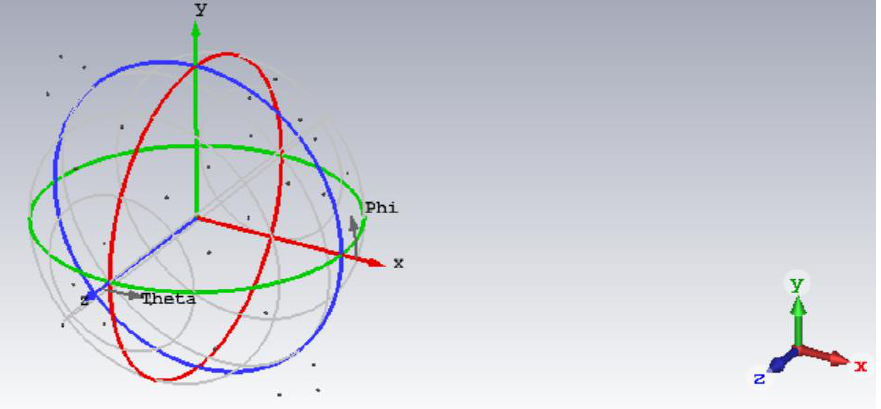
Figure 28. Electromagnetic simulation Experiment Ⅰ model diagram. Table 4. The coordinate positions of 27 metallic spheres.